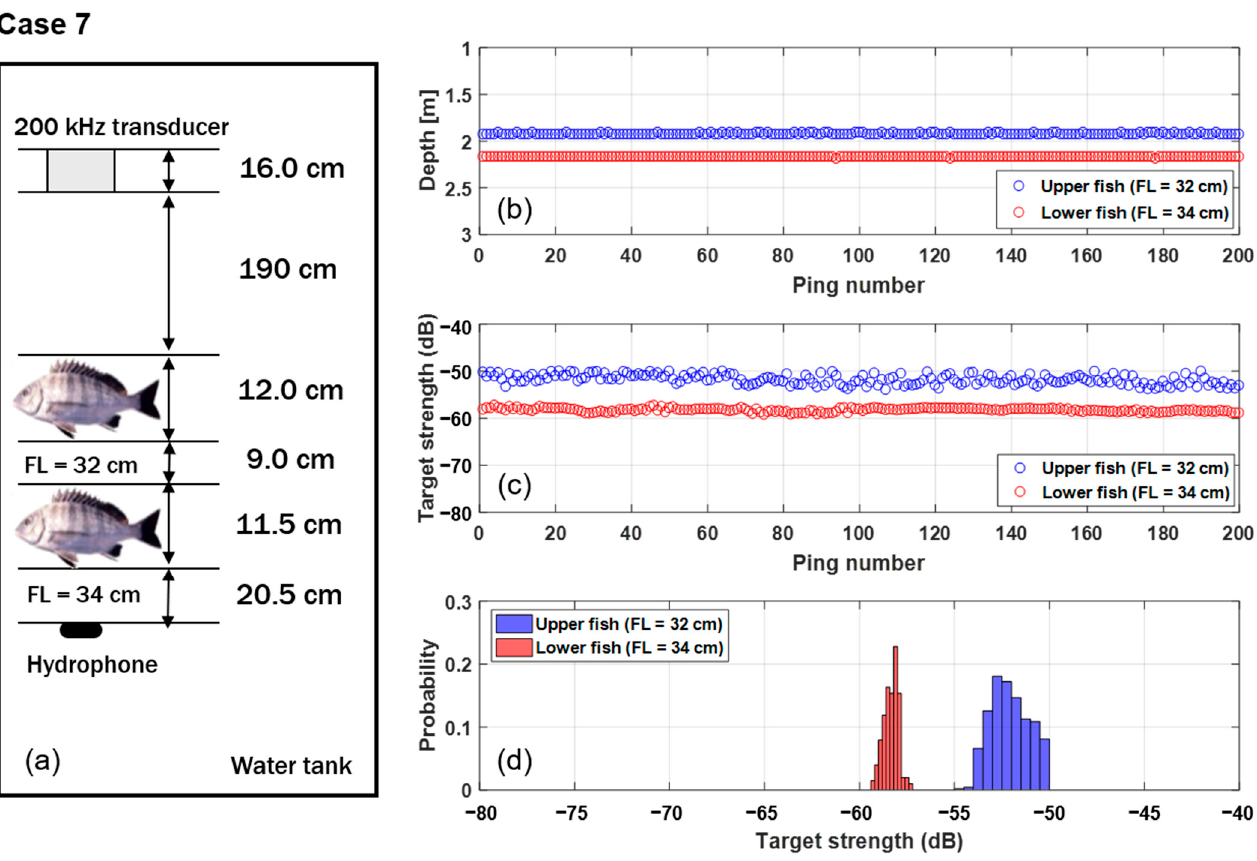
Figure 4. Representative attenuation experiments for case 7 from upper fish (fork length, FL : 32 cm, fish height, H : 12.0 cm) and lower fish ( FL : 34 cm, H : 11.5 cm). ( a ) Experimental setup of the range from the 200 kHz transducer, fish, and hydrophone in the freshwater tank, ( b ) fish depth data, ( c ) target strength (TS) data, and ( d ) the TS histogram from upper and lower fish.